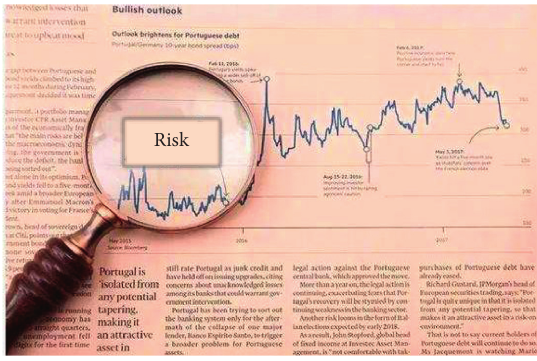
Figure 1: Corporate financial